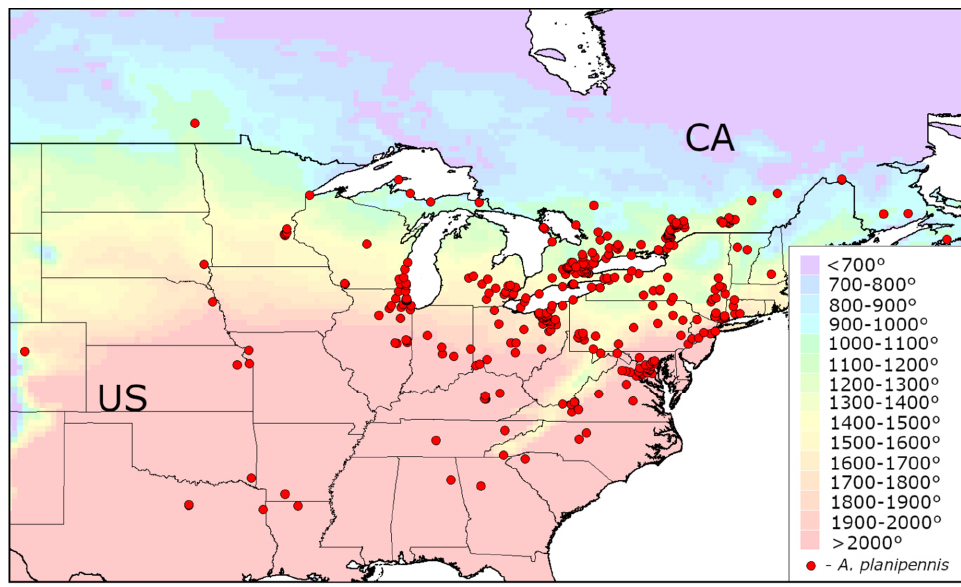
Figure 2. Heat availability in the current invasive range of Agrilus. planipennis in North America. Mean AGDD 10 per year in 2003–2020 is indicated with colours (see the legend). CA—Canada, US— United States. The information about occurrences of Agrilus planipennis was obtained from Emerald Ash Borer Info and Global Biodiversity Information Facility